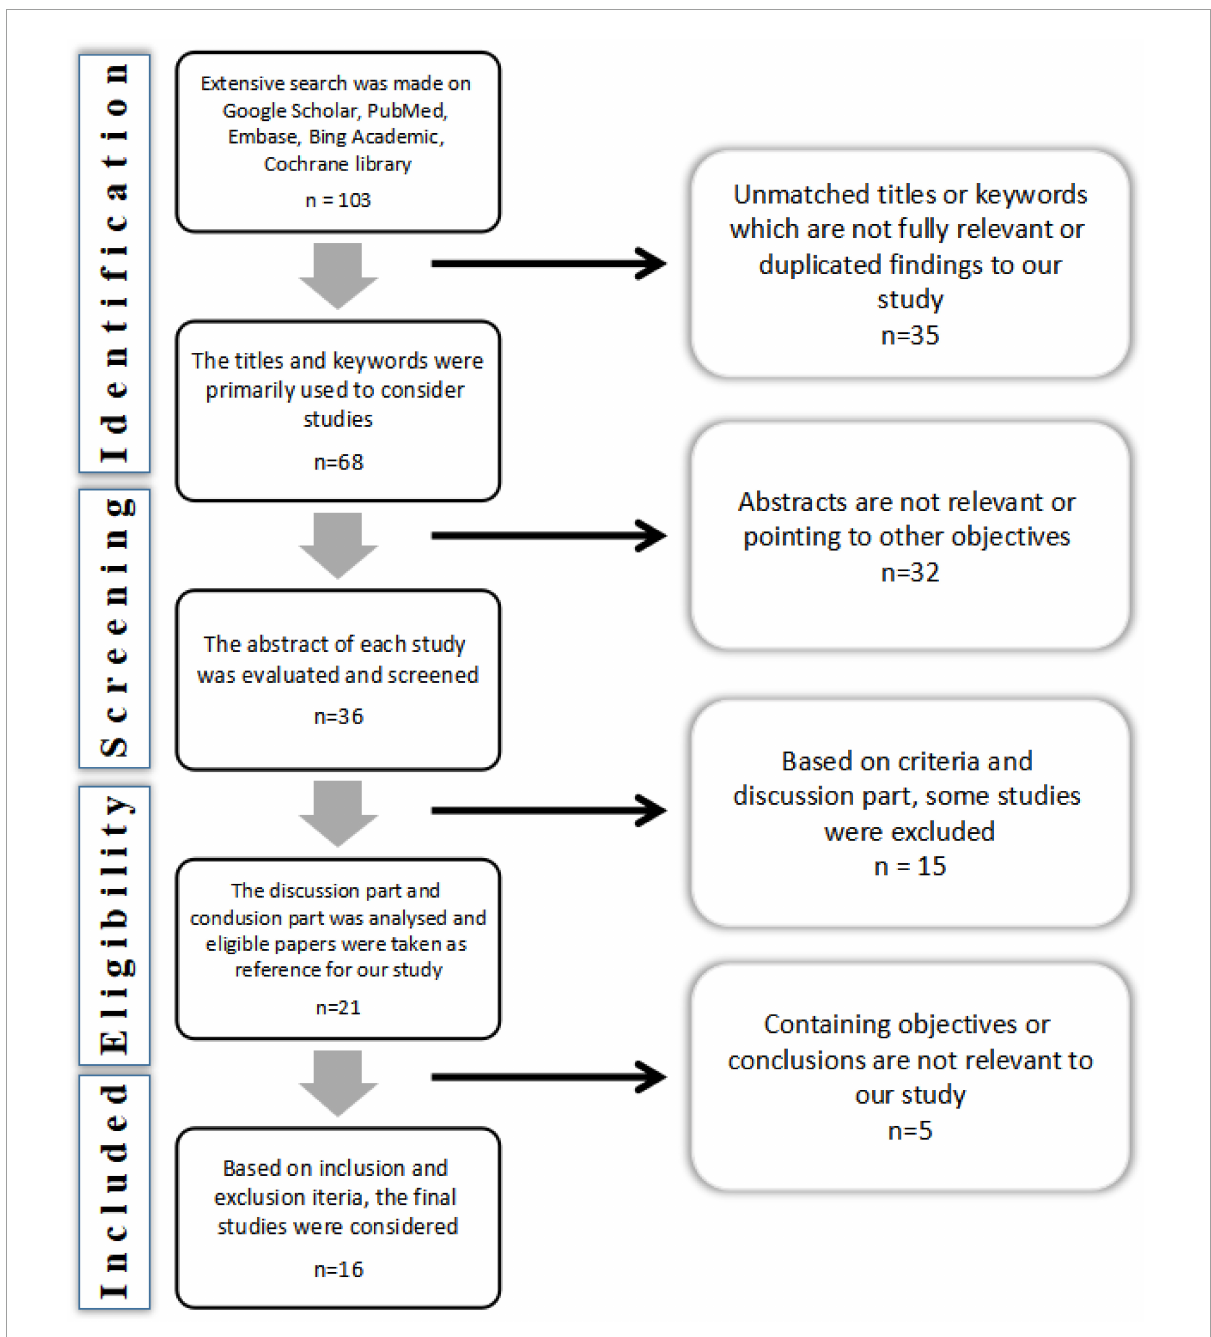
FIGURE3 Preferred reporting items for systematic reviews and meta-analyses (PRISMA) diagram of the